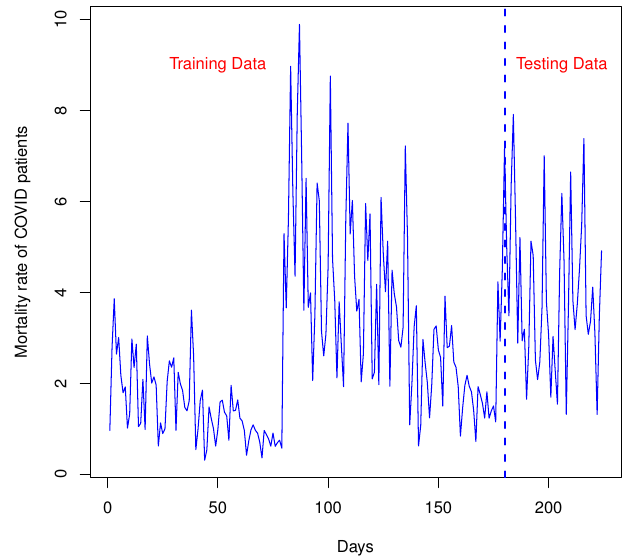
Figure 14. The mortality rate of the COVID-19 patients in Canada.